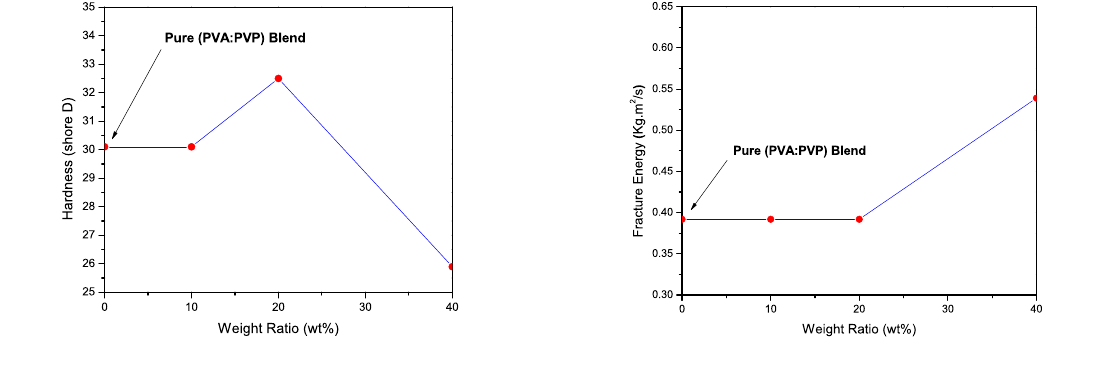
Figure 9: Hardness of pure and PVA:PVP polymer blend films reinforced with different weight ratios of CdCl 2 · H 2 O salt.